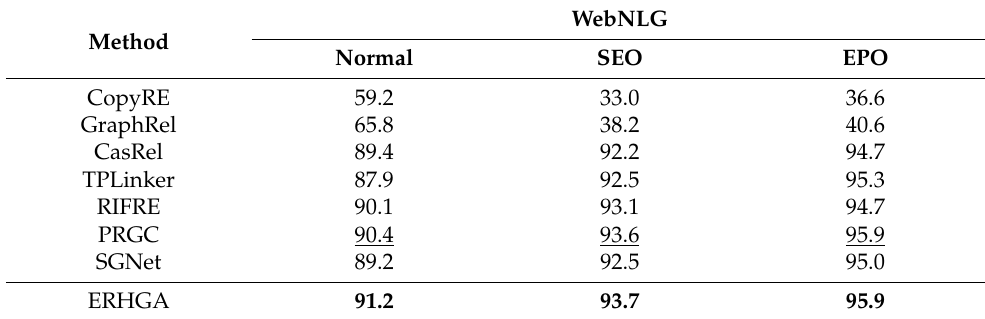
Table 5. F1 (%) on sentences with different overlapping types and different triple numbers.